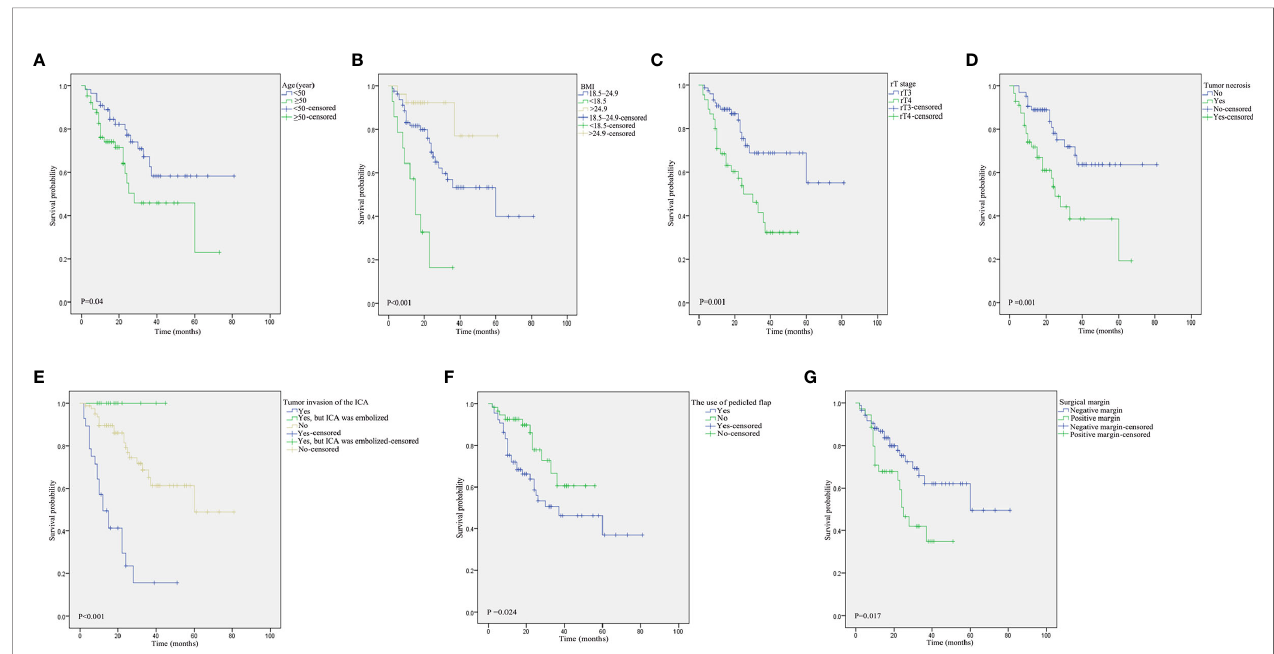
FIGURE 4 | Kaplan – Meier curves pertaining to the overall survival in patients with recurrent nasopharyngeal carcinoma: (A) age ( ≥ 50 vs . <50 years); (B) body mass index (BMI); (C) rT stage (rT3 vs . rT4); (D) tumor necrosis; (E) tumor invasion into the ICA; (F) the use of pedicled fl ap; and (G) surgical